Question: Write a caption explaining this figure to a reader.
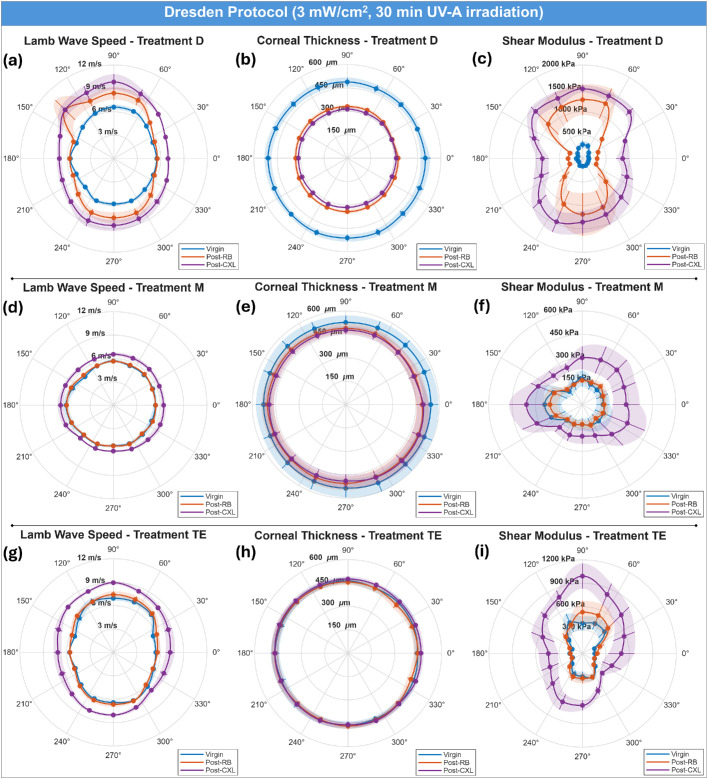
Answer: DP multimeridian estimations. Group average meridian-dependent polar plots of Lamb wave speed ( left ), average corneal thickness ( center ), and estimated shear modulus ( right ) are shown in corneas in the Virgin, Post-RB, and Post-CXL phases when using photosensitizers D ( a , b , c ), M ( d , e , f ), and TE ( g , h , i ) and DP (3 mW/cm 2 , 30 minutes of UV). Scattered points shown mean values within a group. Standard errors (SD) for each meridian are shown in the plots as shadow patterns and bars.